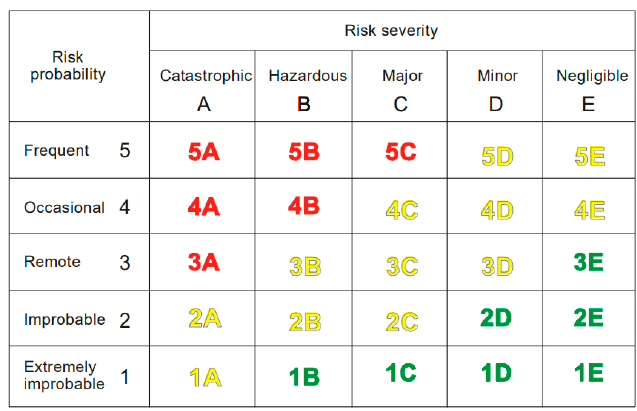
Figure 1. An example of TRM introduced by ICAO (2013).